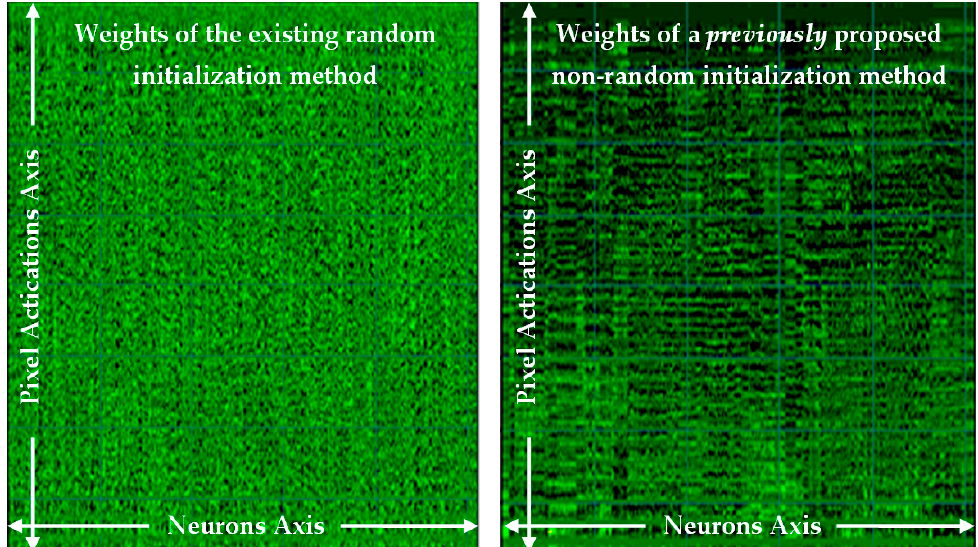
Figure 1. Weight matrix after learning, results from a perceptron only network, ( left ) is an existing random number method, and ( right ) a non-random method reproduced from previous work [16].